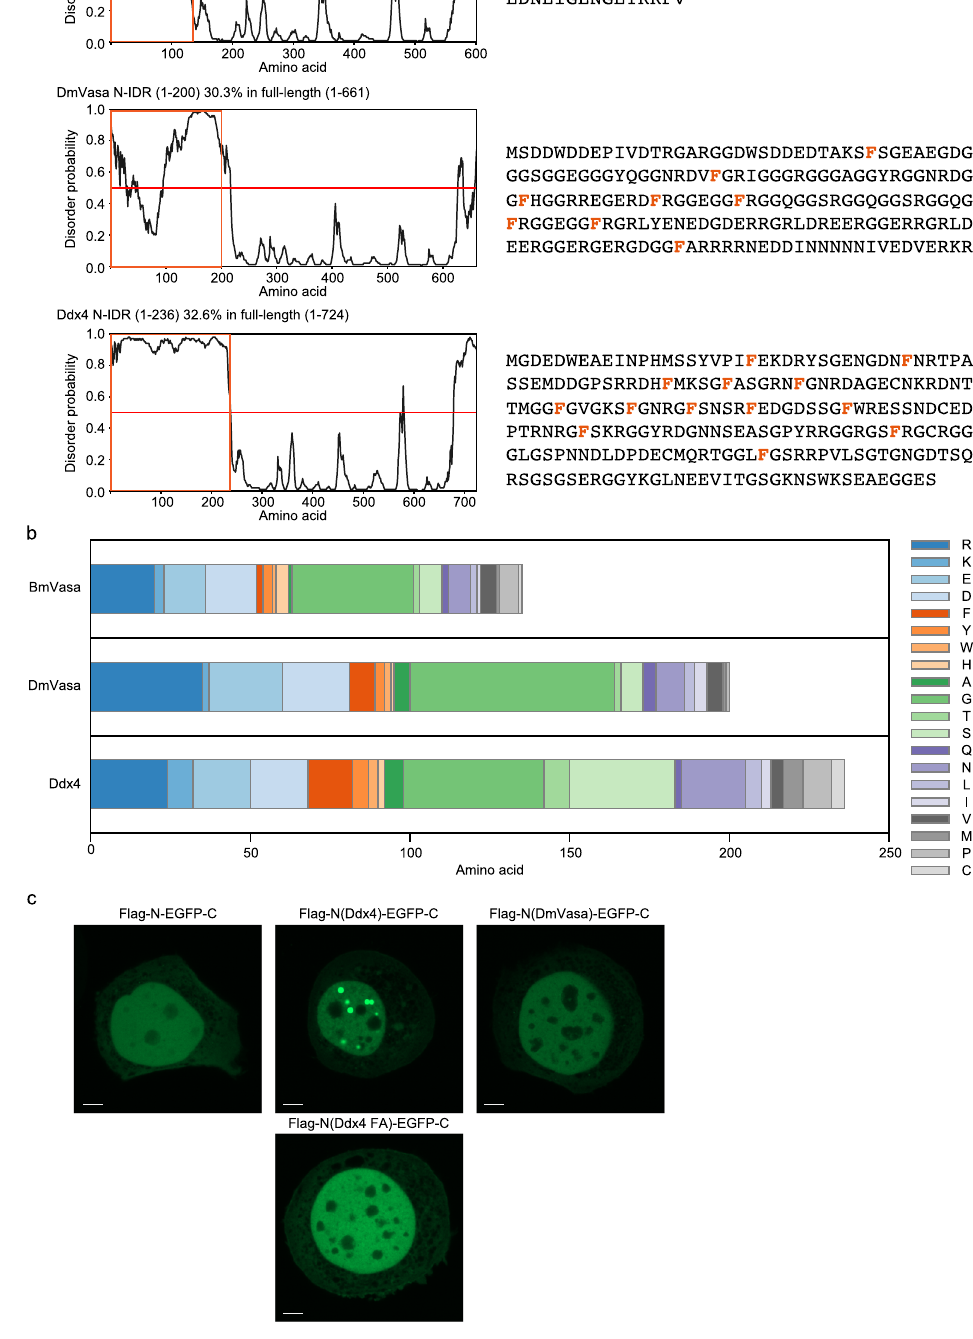
substituted with N-IDR of Ddx4 [Flag-N(Ddx4)-EGFP-C] and DmVasa [Flag- N(DmVasa)-EGFP-C].All14phenylalaninesintheN-terminusofFlag-N(Ddx4)-EGFP- C were substituted to alanine [Flag-N(Ddx4 FA)-EGFP-C]. Flag-BmVasa N-EGFP-C, Flag-N(Ddx4)-EGFP-C, Flag-N(Ddx4 FA)-EGFP-C, and Flag-N(DmVasa)-EGFP-C were expressed in BmN4 cells and their localization was observed based on the EGFP signal. Scale bar: 5 μ m. Source data are provided as a Source Data fi le.